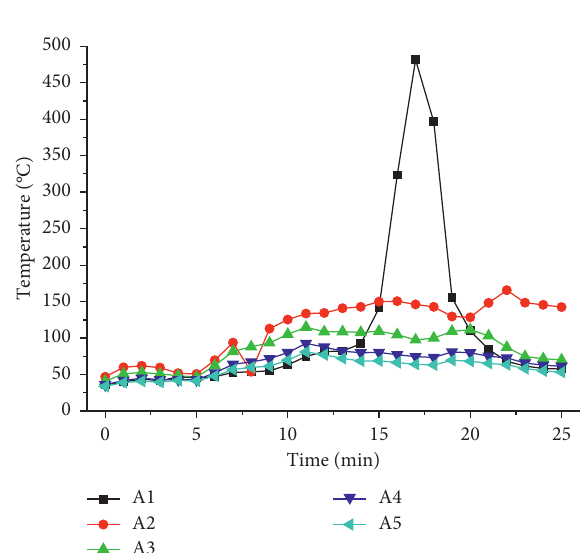
Figure 5: Temperature curves in the tunnel with a double cable with a fan frequency of